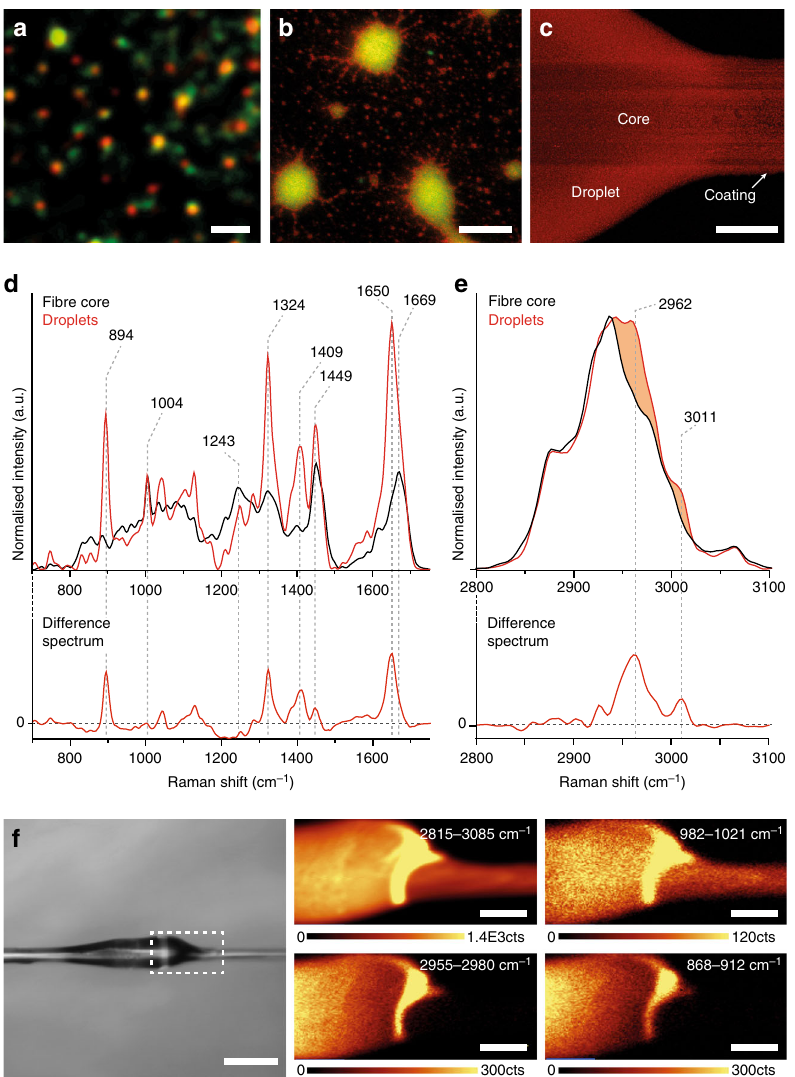
Fig. 3 Compositional analysis of slime fi bres of Euperipatoides rowelli . a STED microscopy on 1:100 diluted slime solution, indicating co-localization of lipid ( red ) and protein ( green ) within nanoglobules ( scale bar = 400 nm) and b within larger nanoglobule agglomerates ( scale bar = 2 µ m). c Confocal microscopy of m-Cling stained fi bre and droplet ( scale bar = 25 µ m). d , e Raman spectra from 700 – 1750 cm − 1 (in d ) and 2800 – 3100 cm − 1 (in e ) of a washed fi bre and fi bre droplet normalized to Phe (1004cm − 1 ), with difference spectra below (coating minus core). f Raman confocal imaging of the fi bre/droplet interface indicated in the microscopy image ( scale bar = 100 µ m) showing integrated peak intensity counts (cts) of the CH band (2815 – 3085 cm − 1 ), Phe peak (982 – 1021 cm − 1 ), and lipid peaks (868 – 912 cm − 1 and 2955 – 2980 cm − 1 ) ( scale bars = 20 µ